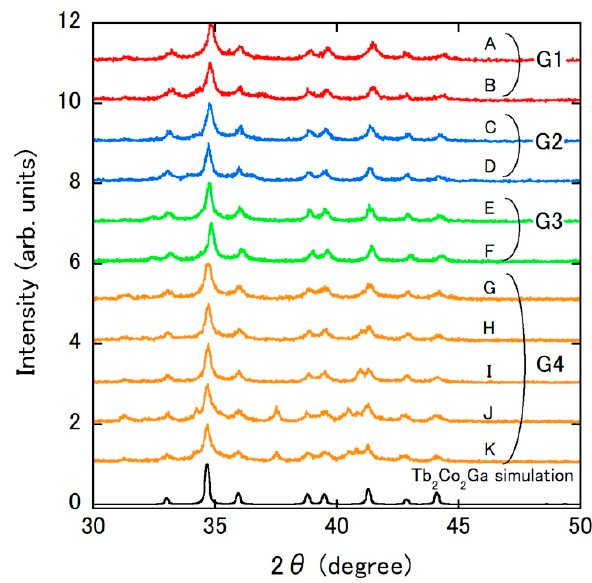
Figure 3. XRD patterns of prepared samples. The simulated pattern of Tb 2 Co 2 Ga with a = 4.103 Å, b = 5.421 Å and c = 8.433 Å is also shown. The origin of each pattern is shifted by an integer value. Back-scattered electron images obtained by FE-SEM with electron beams of 15 keV are shown in